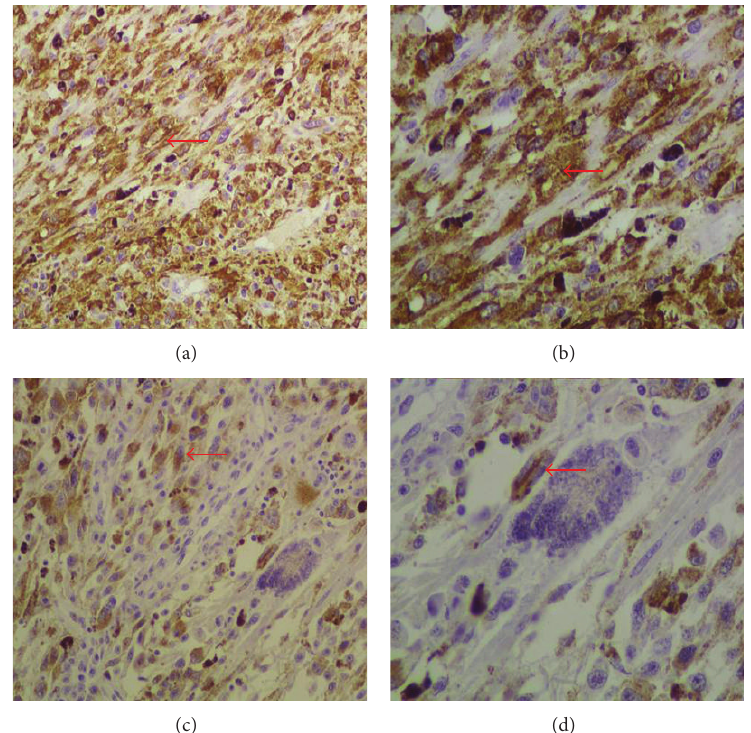
Figure 4: Immunophenotype of tumor cells The neoplastic cells expressed HMB45 ((a, b) red arrows) and microphthalmia transcription factor (MITF) ((c, d) red arrows) (Streptavidin peroxidase (a, c) × 200, (b, d) ×